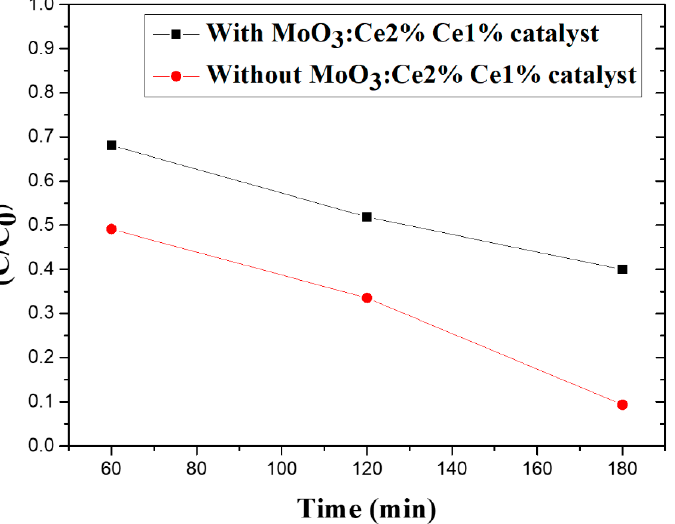
Figure 6. Photodegradation rate (C/C 0 ) of Eosin-Y versus sunlight irradiation time, without and with MoO 3 :Ce 2% Cu 1% catalyst thin film for [S] = 40 × 10 − 3 M.